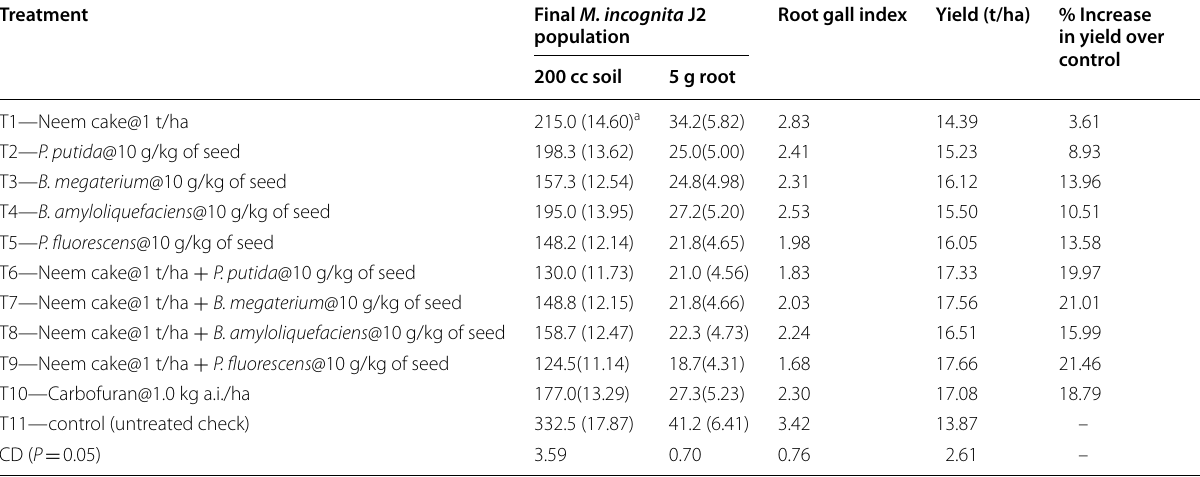
Table 1 Efficacy of different microbial formulations against root-knot nematode (average initial nematode population 200 cc soil) in bottle gourd (Pooled for